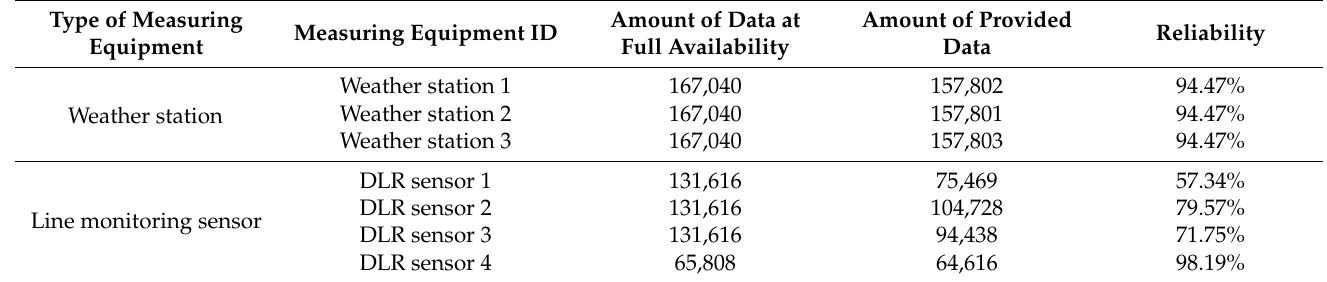
Table 3. Reliability of field measuring equipment.